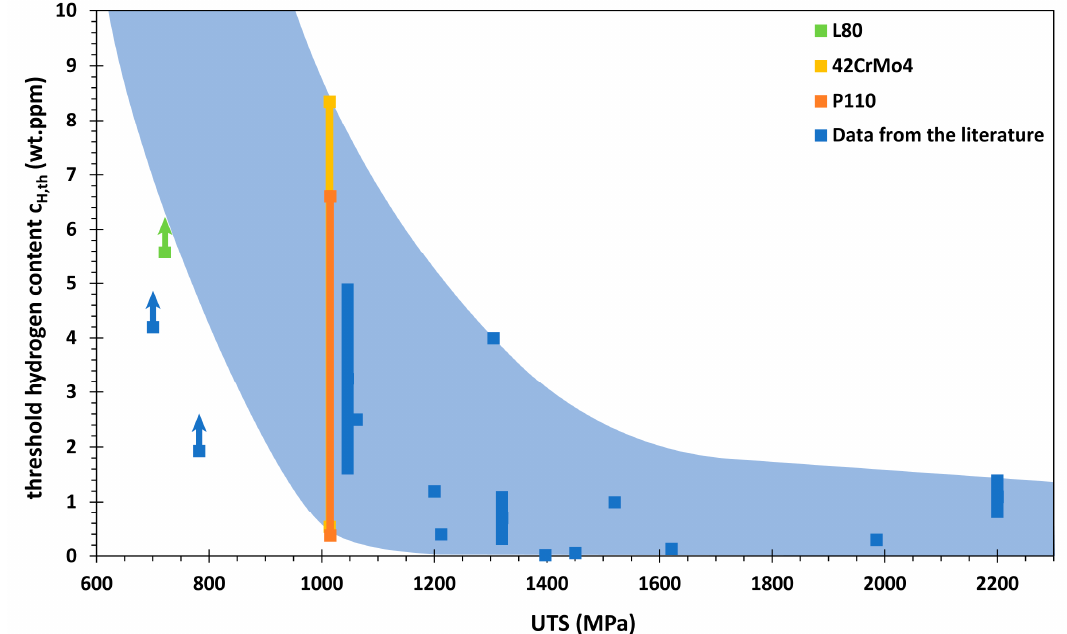
Figure 10. Threshold hydrogen content for hydrogen embrittlement of various martensitic and bainitic steel grades. Literature data from [19–24,42–44,52–54], missing values for UTS were estimated with YS×1.10.